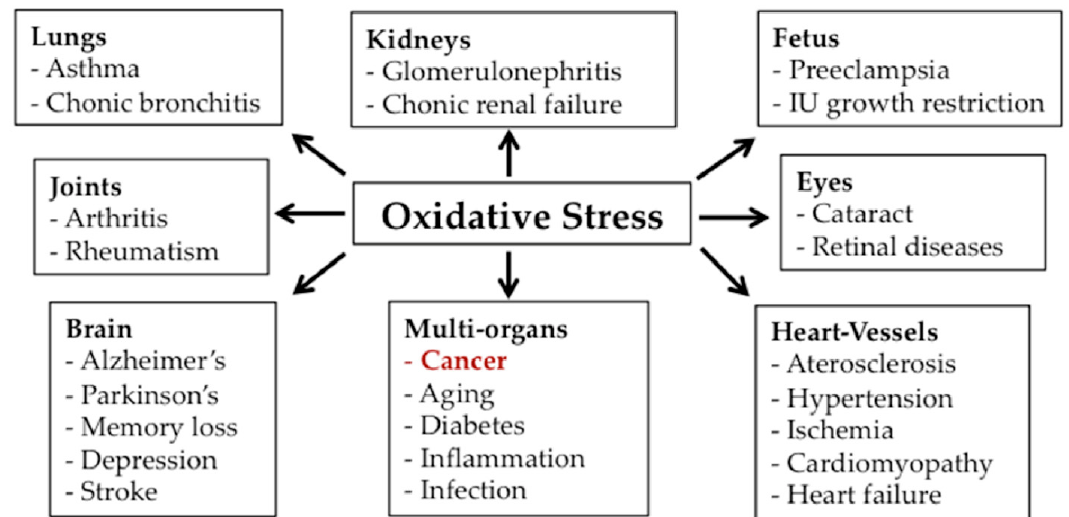
Figure 2. Oxidative stress represents a hallmark of several human diseases.